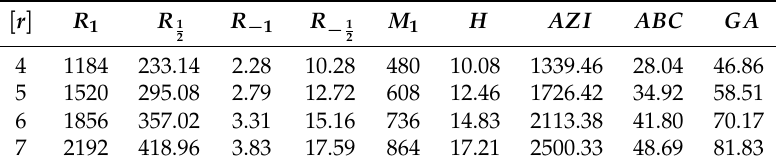
Table 8. Numerical computation of all indices for CHDN 3 ( r )